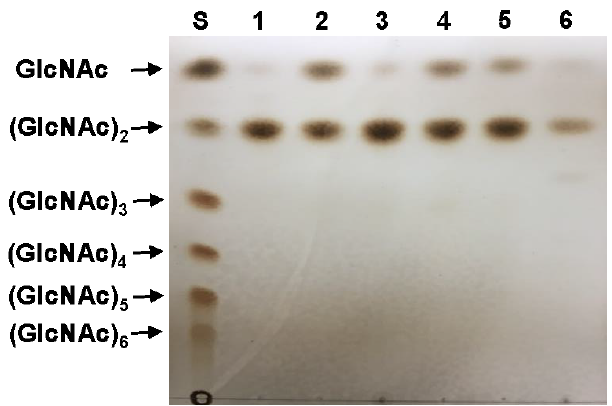
Figure 6. TLC analysis of the hydrolysis products of N -acetyl- β - D -COSs of (GlcNAc) 2 to (GlcNAc) 6 and colloidal shrimp shell chitin by rChiJ: Lane S, standard markers [GlcNAc to (GlcNAc) 6 ]; lanes of 1 to 5, the reaction of rChiJ with N -acetyl- β - D -COSs [(GlcNAc) 2 to (GlcNAc) 6 , each 1 mg]; lane 6, the reaction of rChiJ with colloidal shrimp shell chitin.